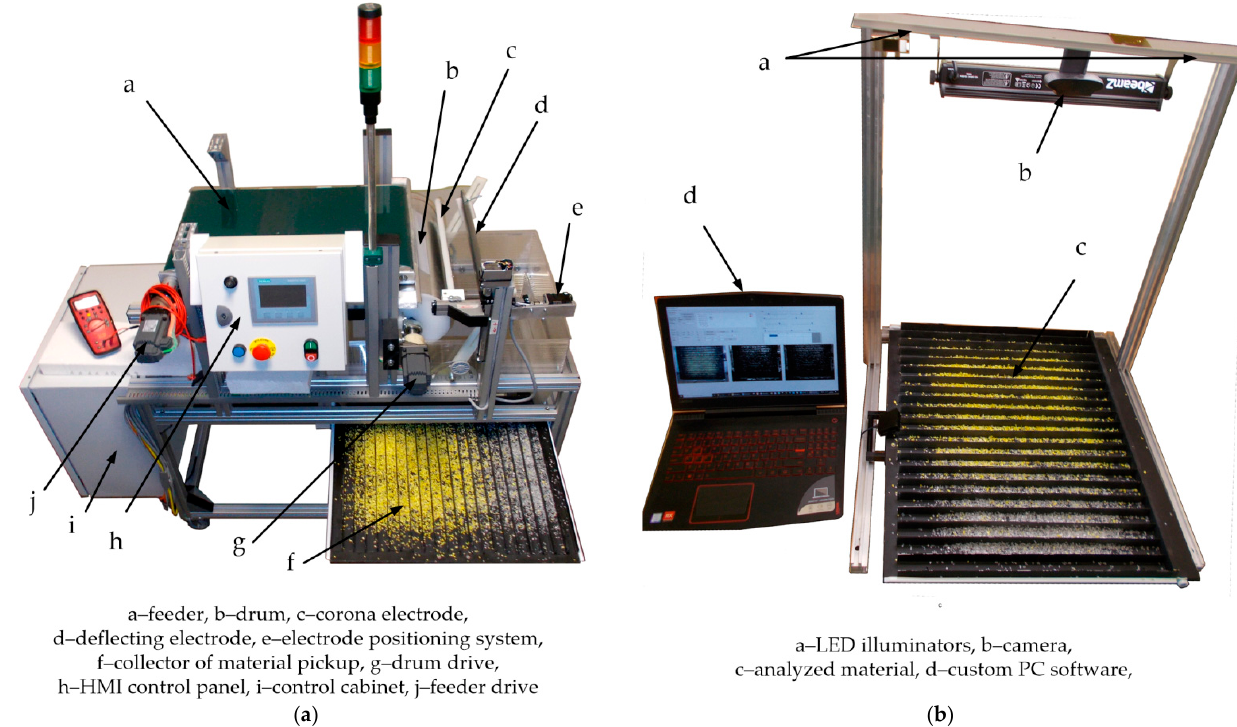
Figure 9. The view of electrostatic separator ( a ) and stand for the vision system ( b ).